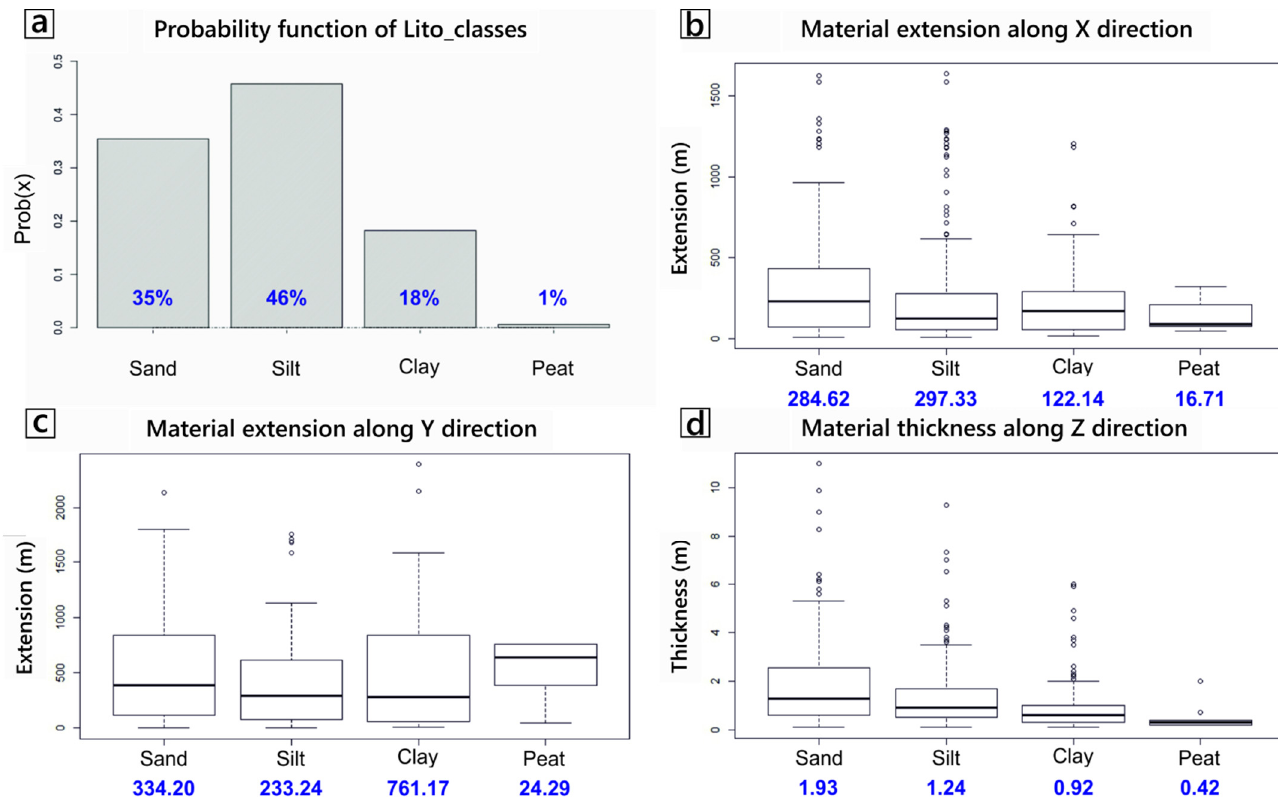
Figure 5. ( a ) Relative volumetric proportion of the four “materials” in the modelled WAA. ( b – d ) Box plots of the mean length of the four materials (in meters), respectively along the x, y and z direction.